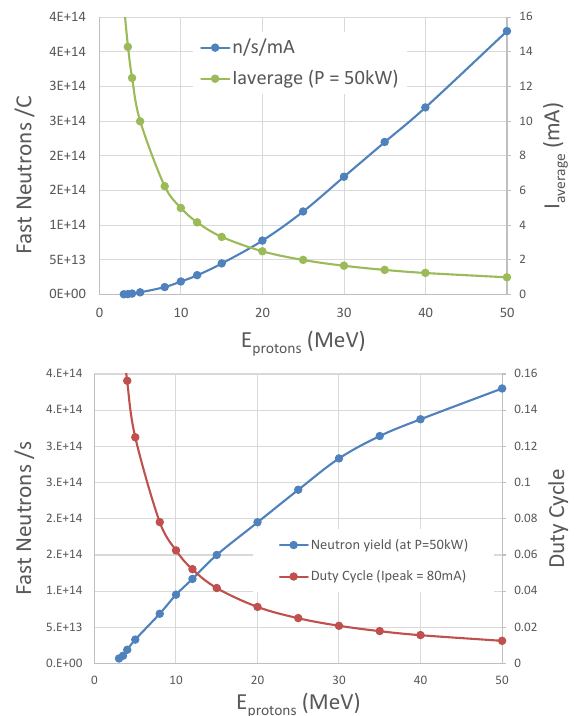
Fig. 3. (a) Neutron yield per Coulomb versus proton energy and maximum average current to limit the power on the target at 50 kW. (b) Actual yield with a power limit on the target set at 50 kW and corresponding duty cycle (for I peak = 80mA). While the neutron yield per proton doubles from E p = 20 to 30 MeV, power limits on the target reduce the gain to 45%. In parallel, the duty cycle on the target is reduced (from 3% to 2% if I peak = 80 mA) which makes the neutron pulses easier to exploit for scattering experiments. From 20 MeV to 30 MeV the gain in flux is roughly proportional to the accelerator energy. From 30 MeV to 50 MeV, the gain in flux is 36% while the proton energy is increased by 67%.